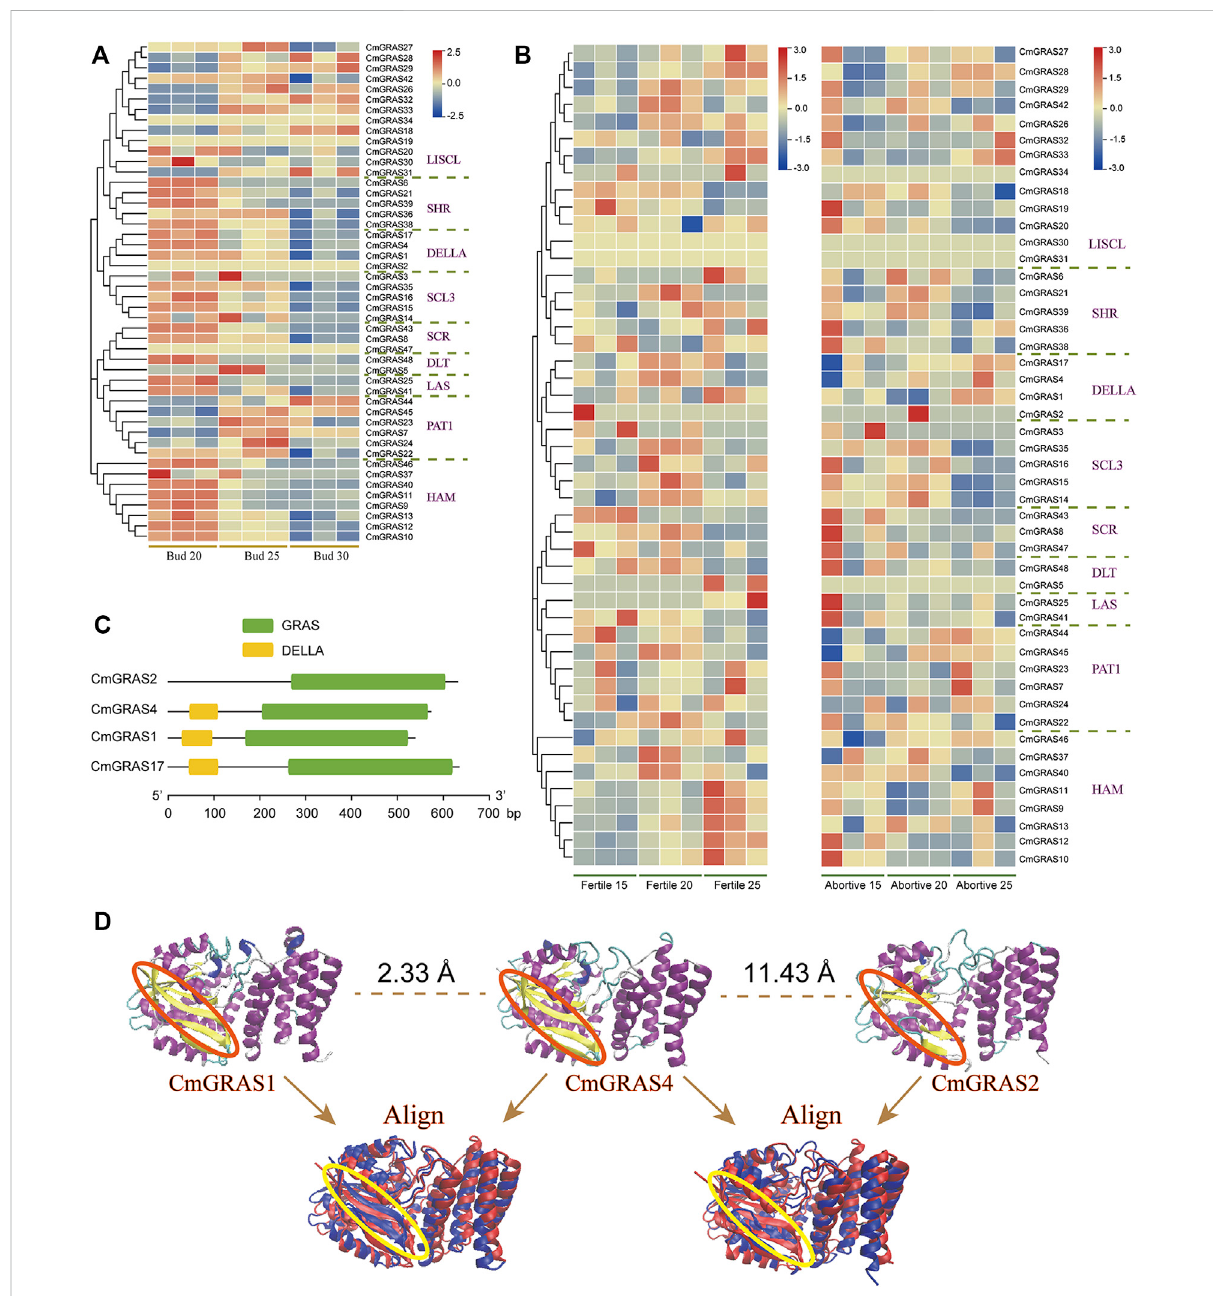
functionalization of the CmGRAS2 gene at the bud development stage. Although some CmGRAS members formed by tandem duplication had great differences in expression, they usually had similar expression patterns. For example, the expression